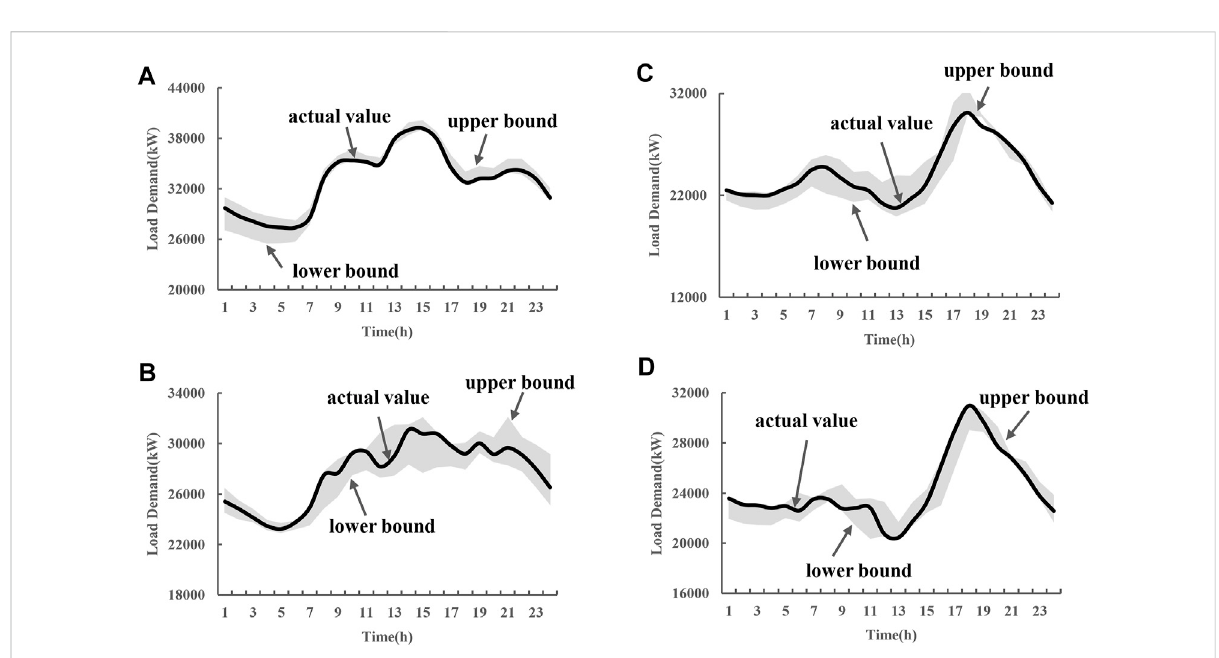
FIGURE 5 Loaddemandforecastingresultsof (A) typicalweekdayinsummer, (B) typicalweekendinsummer. (C) Typicalweekdayinwinterand (D) typical weekend in winter.